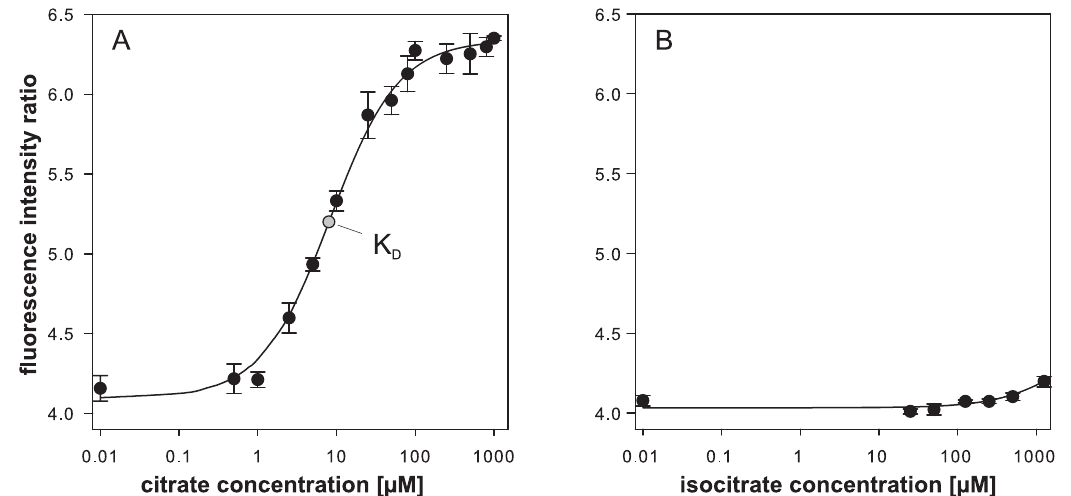
Figure 2. Binding curve of citrate to the FRET nanosensor CIT8 m . The FRET sensor CFP-truncated CitA-Venus was purified and the fluorescence emission of CFP and Venus recorded at an excitation of 433 nm in a fluorescence plate reader. The emission ratio 530/488 nm was determined at different citrate (A) and isocitrate (B) concentrations. Data points are averages of three independent protein extractions. Error bars indicate standard deviations. Data were fitted to a single site binding curve (black line) as described in the method section.